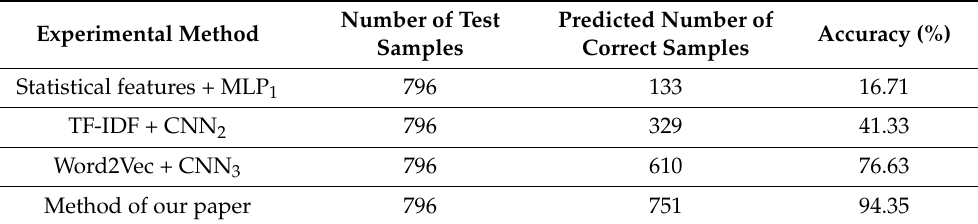
Table 8. Generalization test